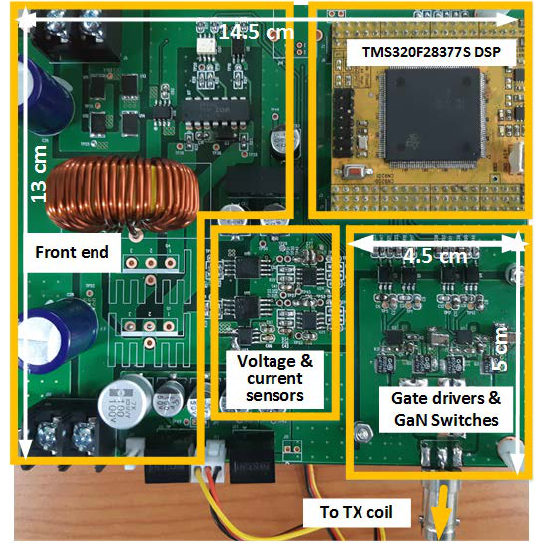
Figure 13. A photo of the assembled H-bridge inverter.